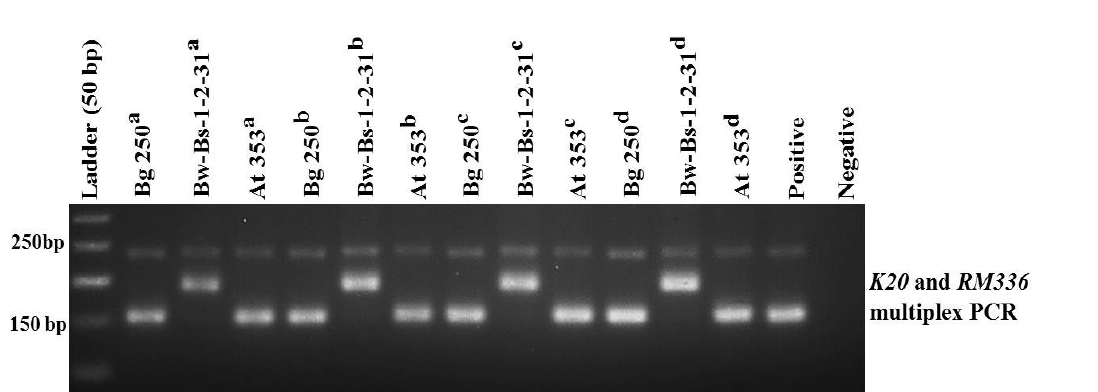
Figure 3: Agarose gel image of the multiplex PCR with K20 and RM336 markers (2.5% agarose gel electrophoresis). The 50 bp ladder was used as the size standard. The key band sizes of the ladder are indicated on the left side. Names of the rice varieties/lines are given on the top. a: CTAB method, b: modified CTAB method, c: Promega kit, d: Qiagen kit.